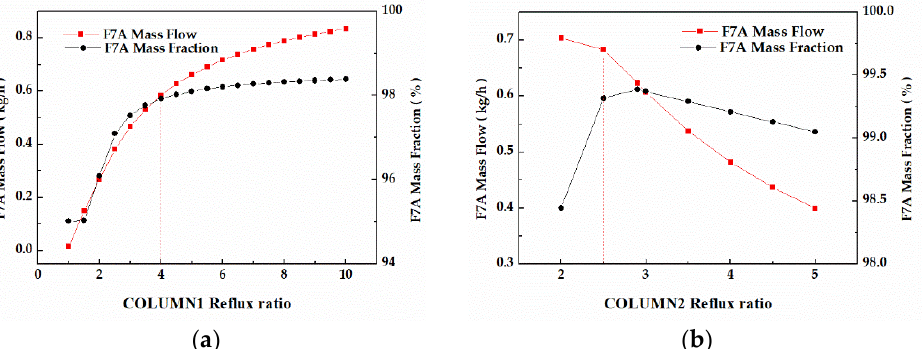
Figure 10. ( a ) Effect of reflux ratios on F7A mass fraction and F7A mass flow in stream W1. ( b ) Effect of reflux ratios on F7A mass fraction and F7A mass flow in stream D2.